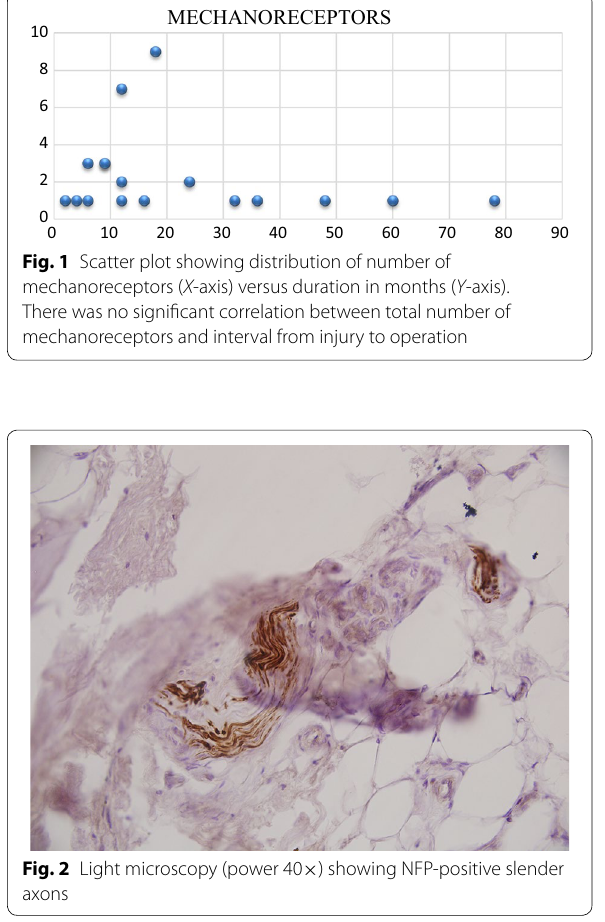
) showing NFP-positive slender ×